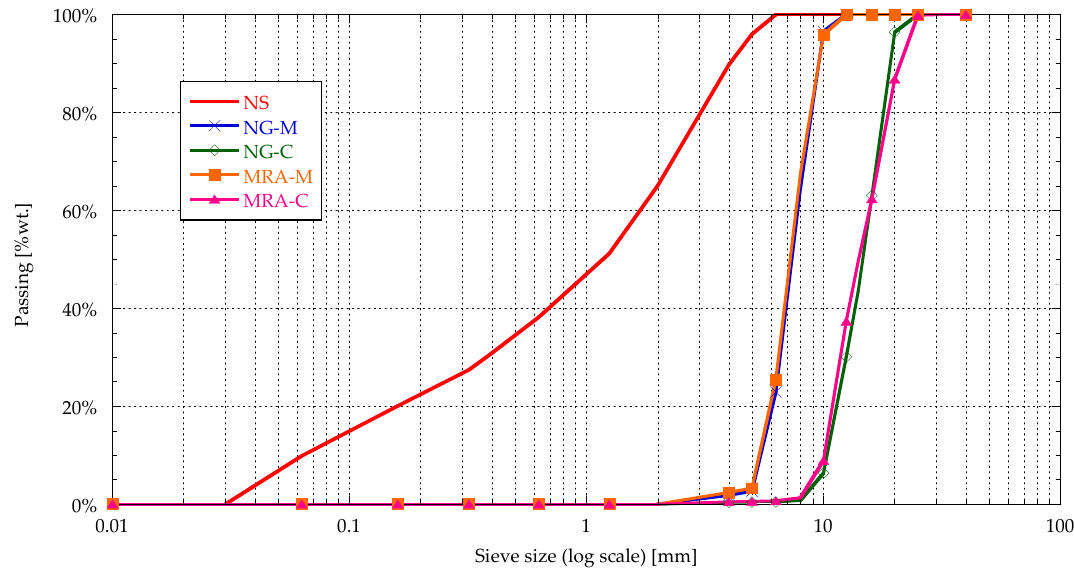
Figure 1. Grading of the aggregates.